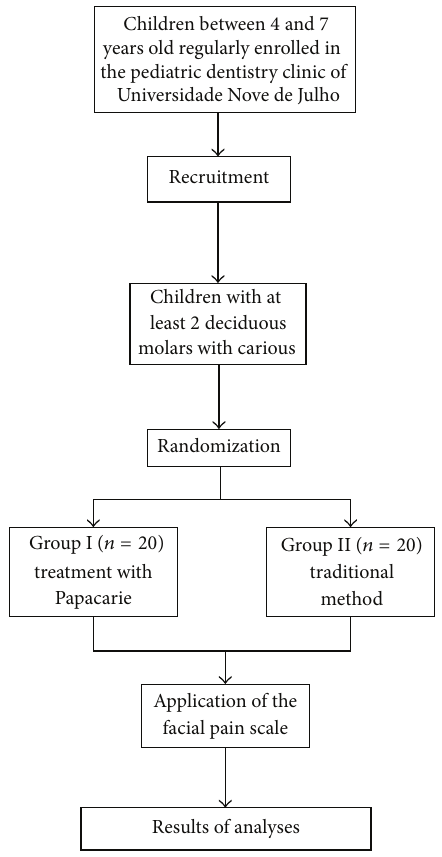
Figure 1: Flow chart of the